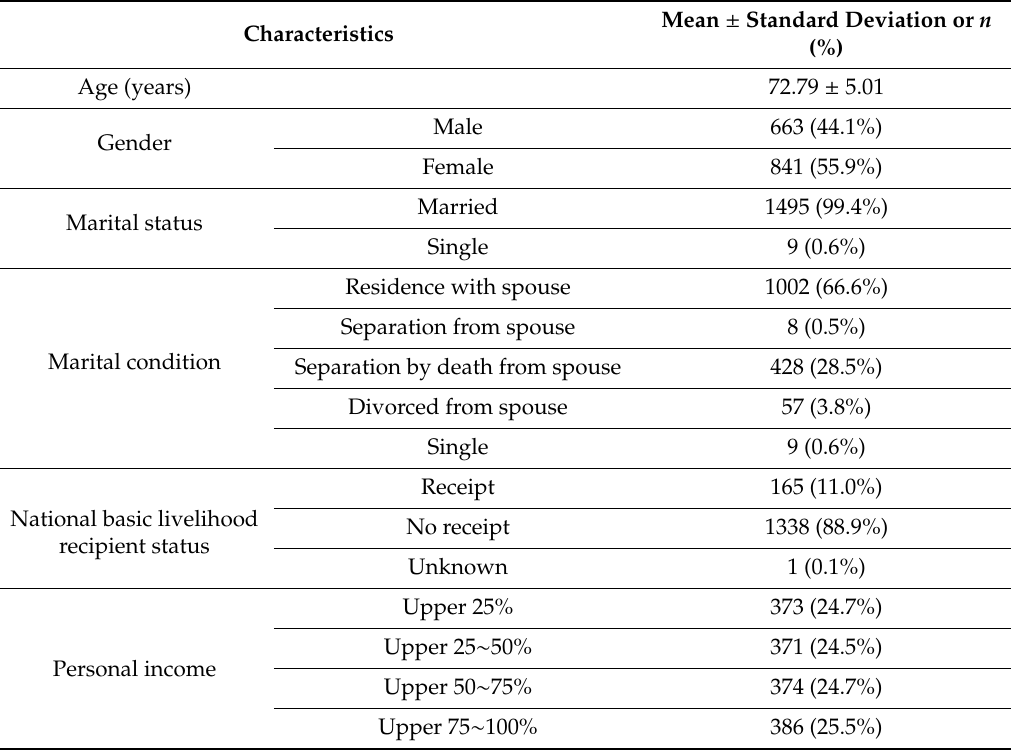
Table 1. General participant characteristics ( n =